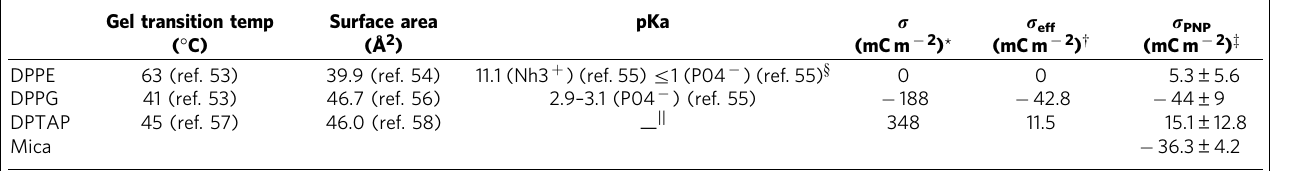
Thelipids were all expected to be in gel phase at room temperature, and literaturevalues for surface areaand dissociation constants are, as faras possible, matching the experimentally used conditions. *Surface charge density calculated from the Gouy–Chapman–Helmholtz–Stern